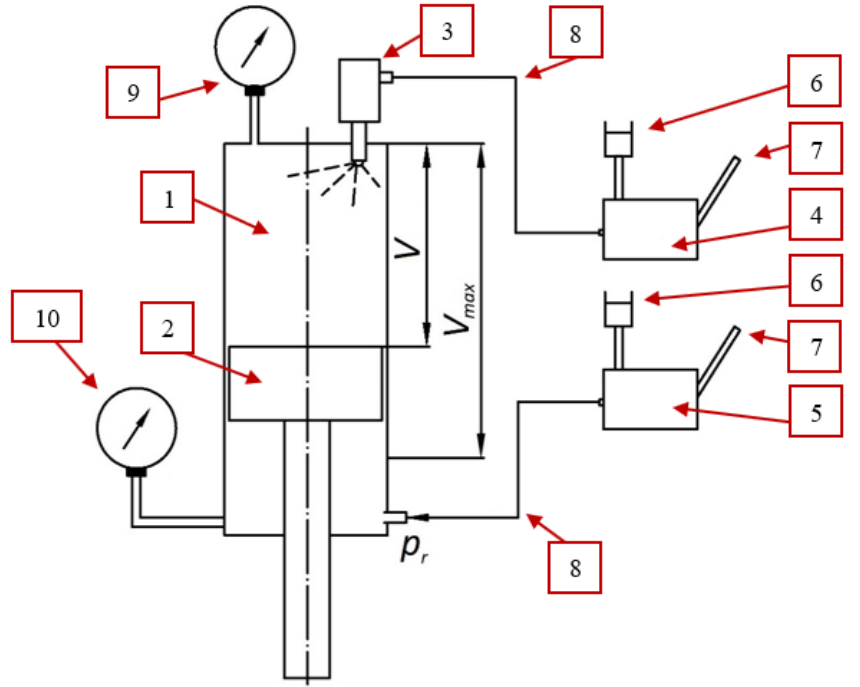
Figure 2. Diagram of the method of measurement of the coefficient of solubility and bulk modulus: 1—cylinder of the hydraulic actuator, 2—piston of the hydraulic actuator, 3—injector, 4—pump, 5—pump supplying the fuel under the piston, 6—fuel tank, 7—pump lever, 8—high pressure line, 9—manometer, 10—manometer measuring the pressure under the piston ( p r ).